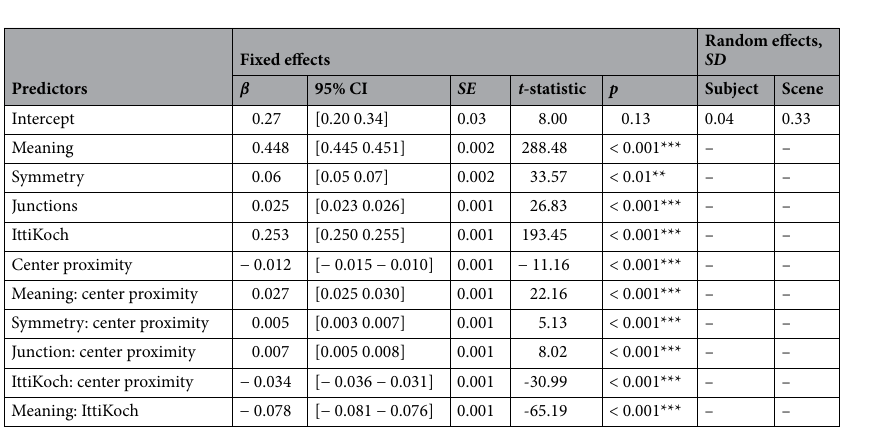
Table 3. DeepGaze II LME results. Beta estimates ( β ), 95% confidence intervals (CI), standard errors (SE), t values, and p values ( p ) for each fixed effect and standard deviations ( SD ) for the random effects of subject and scene.